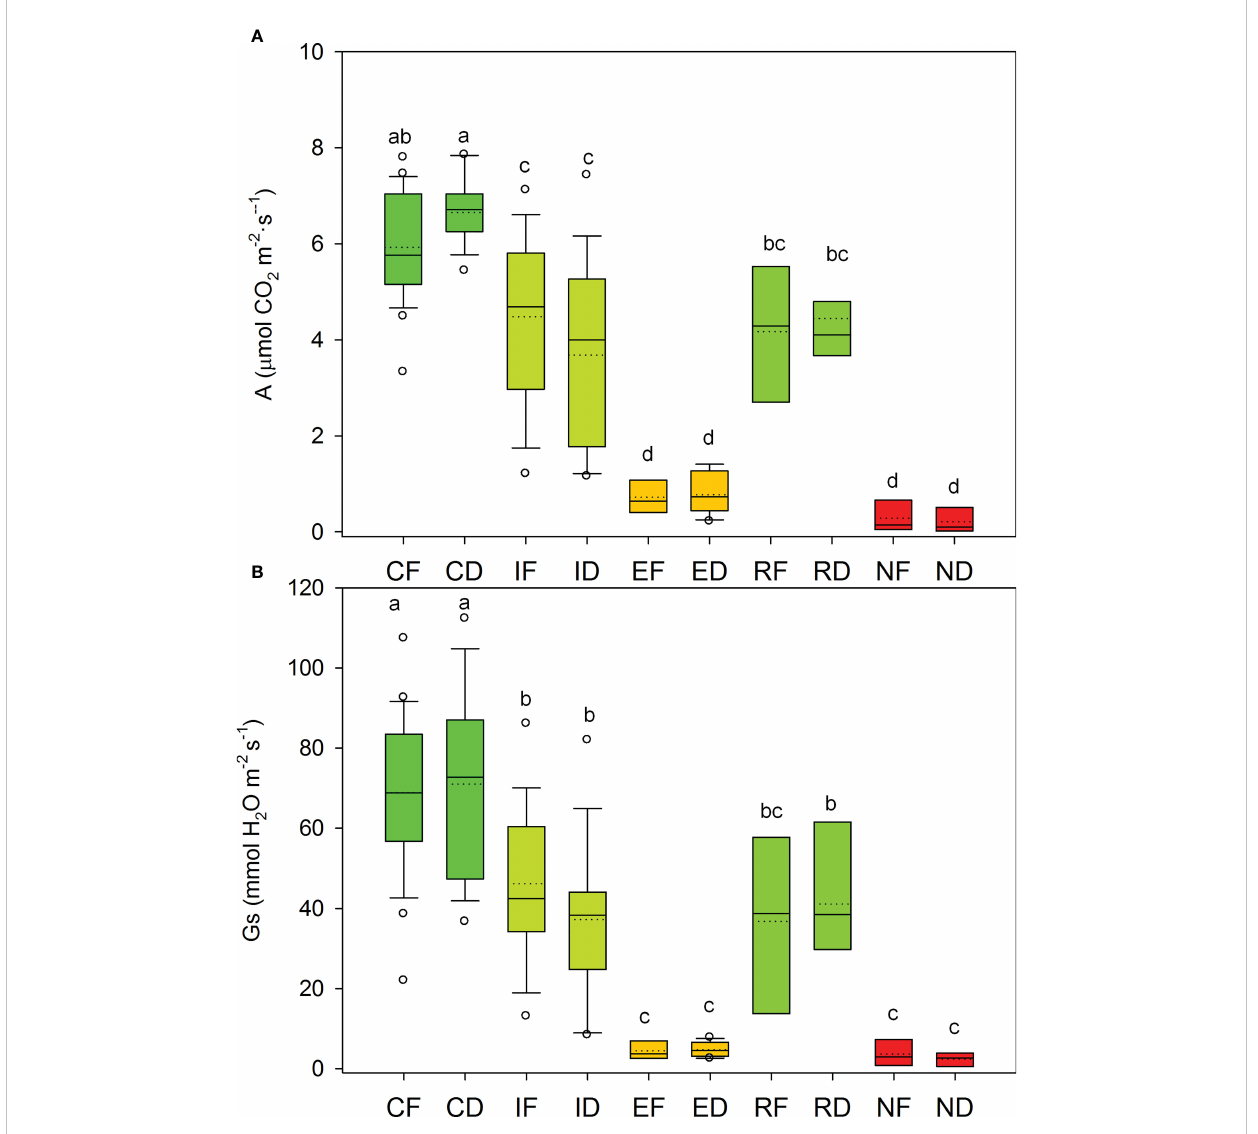
FIGURE 3 Net photosynthesis, A (A) and stomatal conductance, Gs (B) measured in seedlings from Fiñana (F) and Dornajo (D) subjected to treatments: control (C), immediate drought (I, after 24 hours of drought treatment), and extended drought (E, after 20 days of drought treatment).The E group was divided into drought resilient seedlings (R) and non-resilient seedlings (N), based on recovery capacity after the extended drought. Groups are noted by the treatment/response (C, I, E; R, N) and population codes (F, D). Different letters indicate signi fi cant diferenteces (p<0.05) by ANOVA.